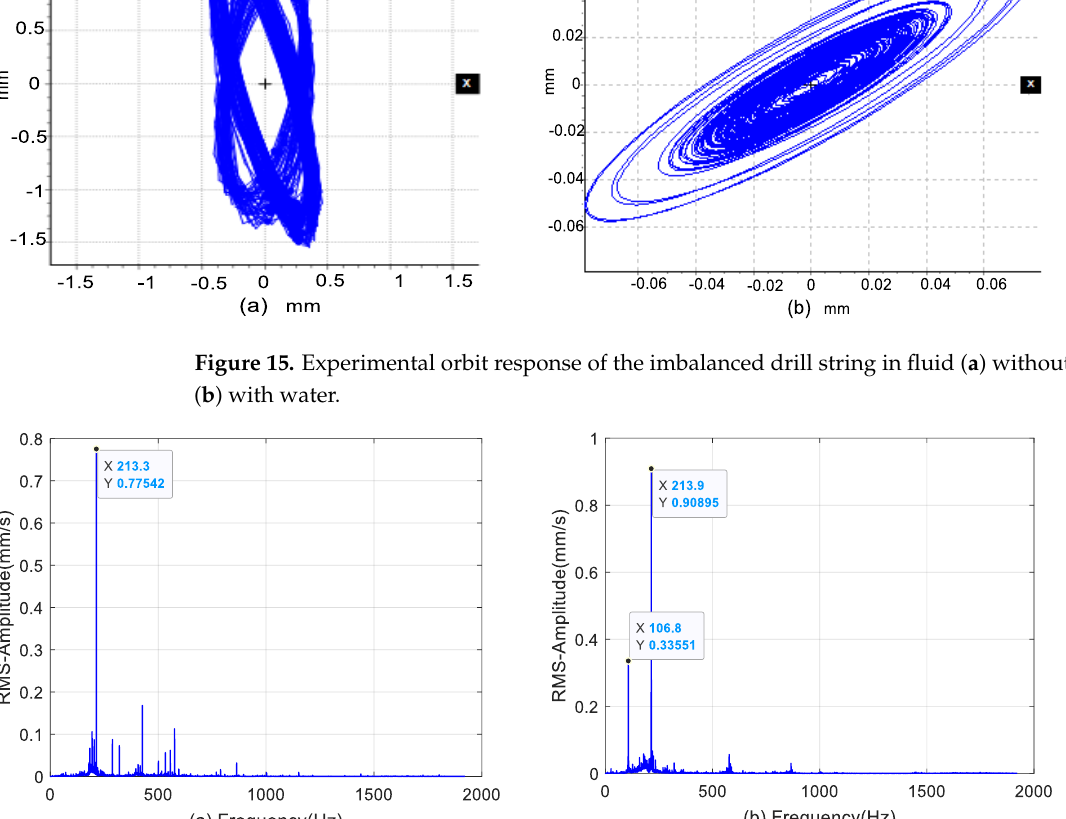
Figure 17. Experimental response of imbalance and rotor-casing rub ( a ) without water and ( b ) with water.